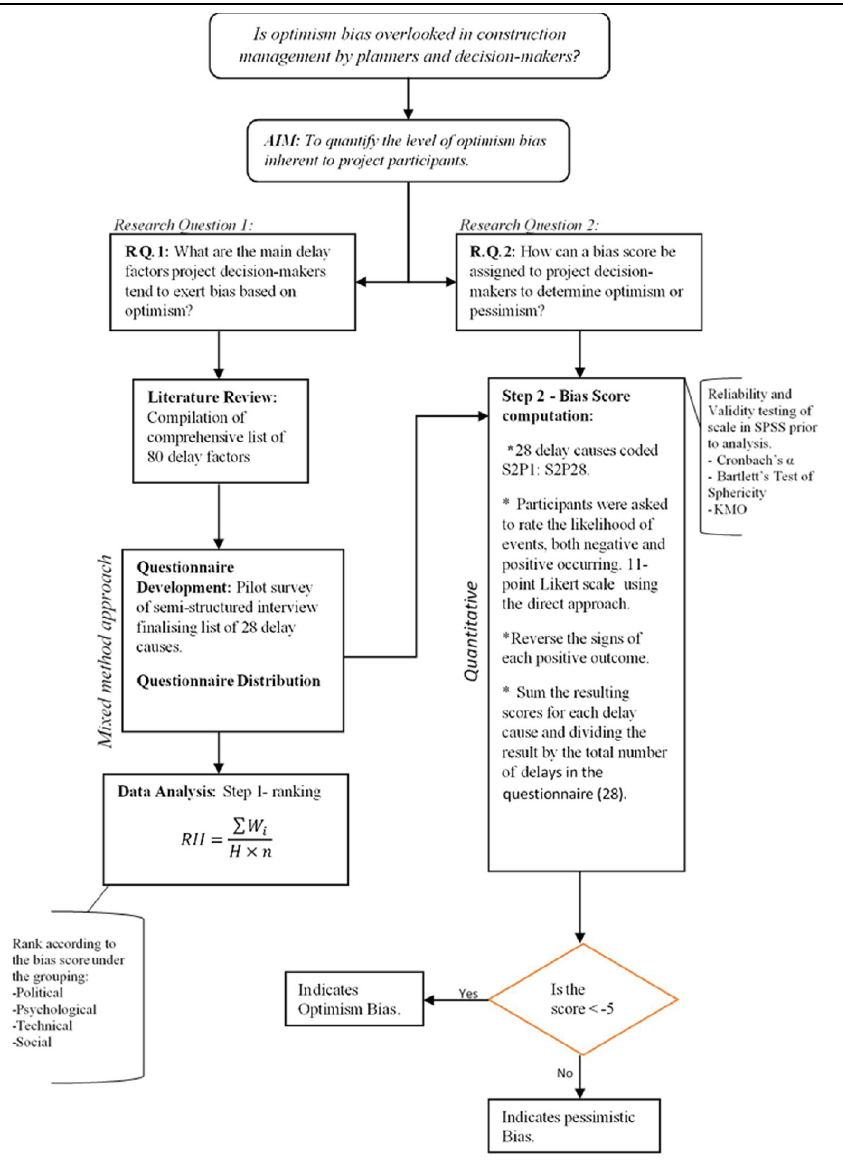
Figure 1. Flowchart of research